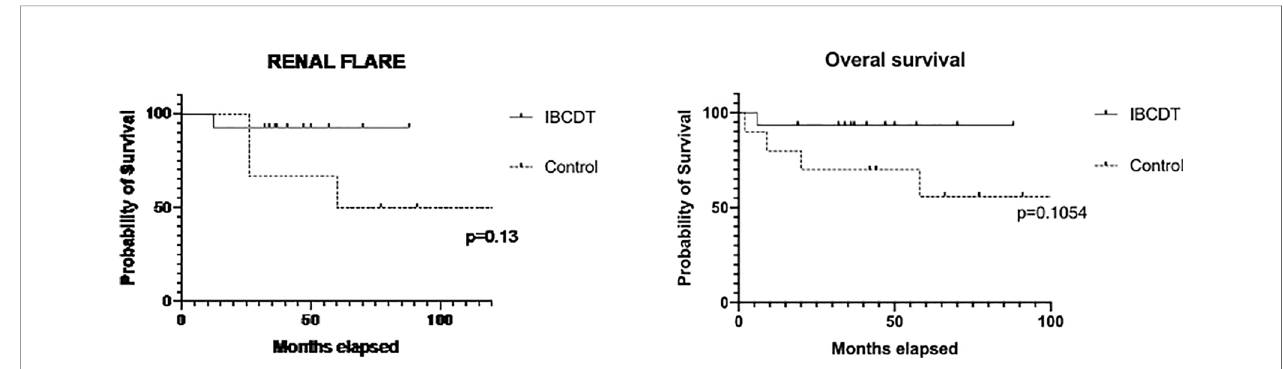
FIGURE 1 | Time free from renal fl ares and overall survival (Kaplan – Meier curves) in IBCDT-treated patients and controls. IBCDT, intensi fi ed B-cell depletion induction therapy. Renal fl ares were evaluated excluding patients who died during the